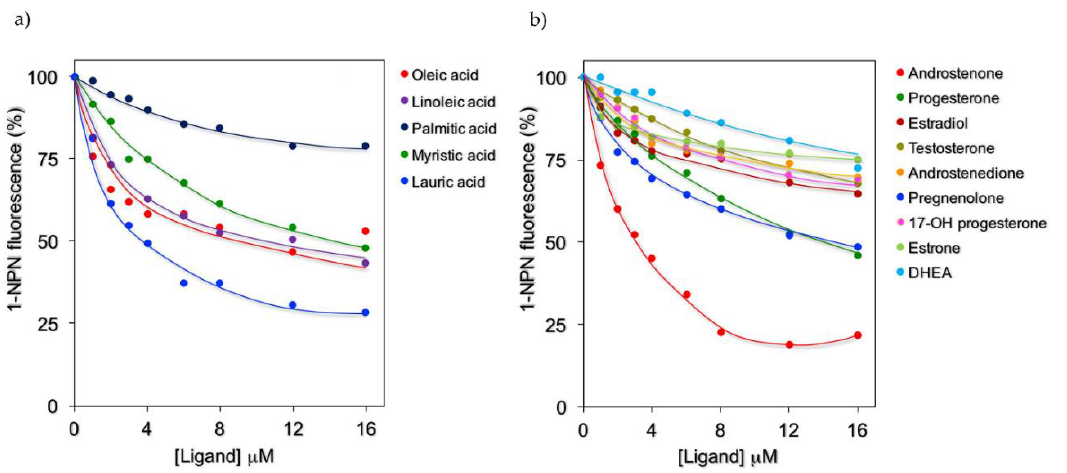
Table 2. Affinities of different ligands to rFel d 1, evaluated in competitive binding assays .